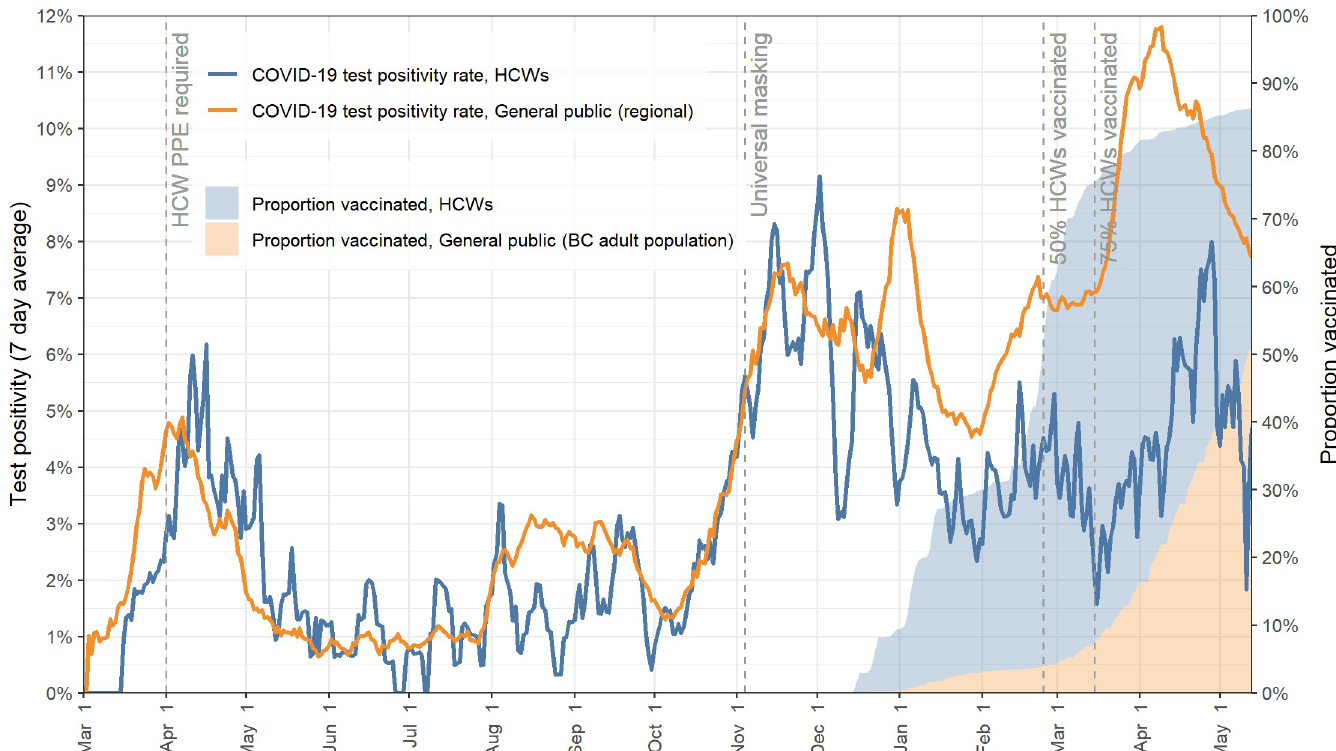
Fig 2. COVID-19 positivity rate and vaccine coverage in in healthcare workers of Vancouver Coastal Health compared to general population in area of residence over time.